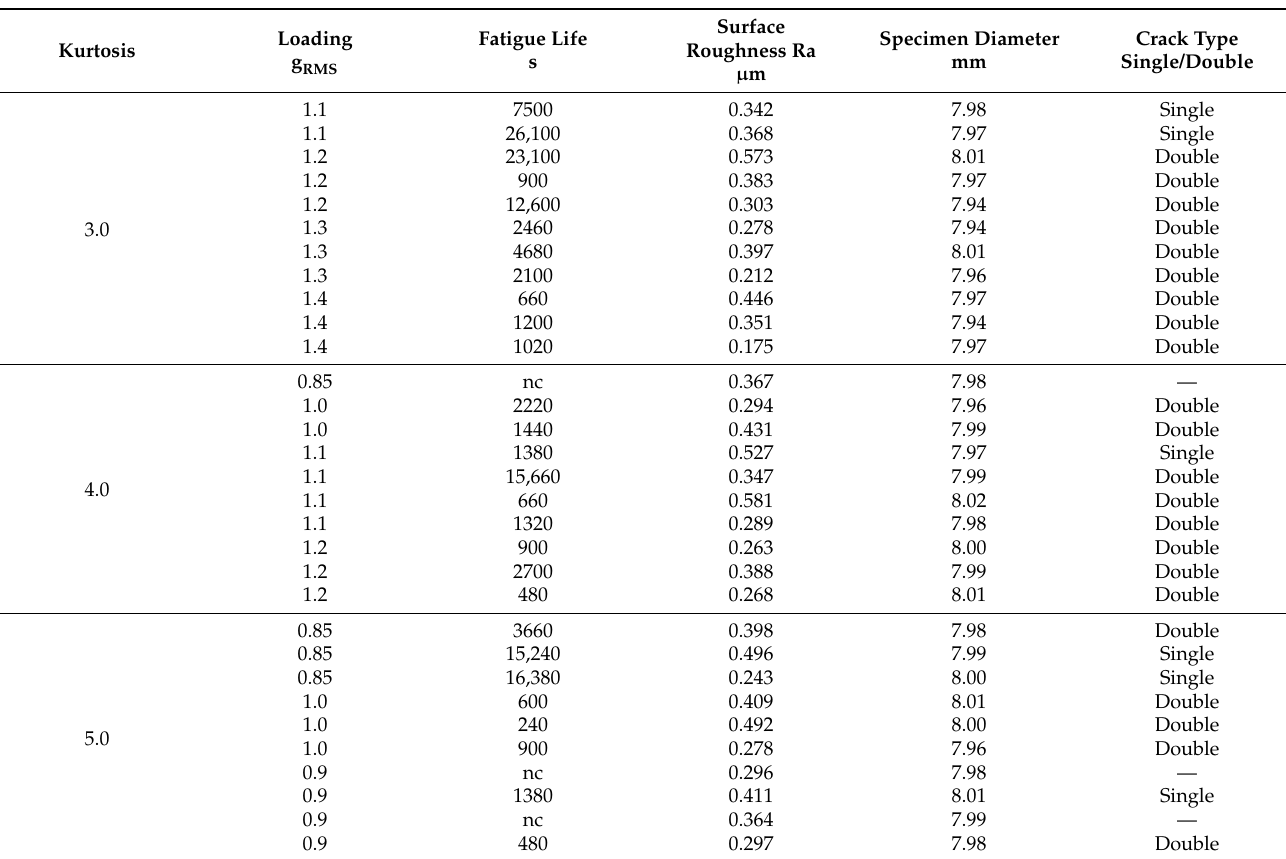
Table 4. Experimental results.